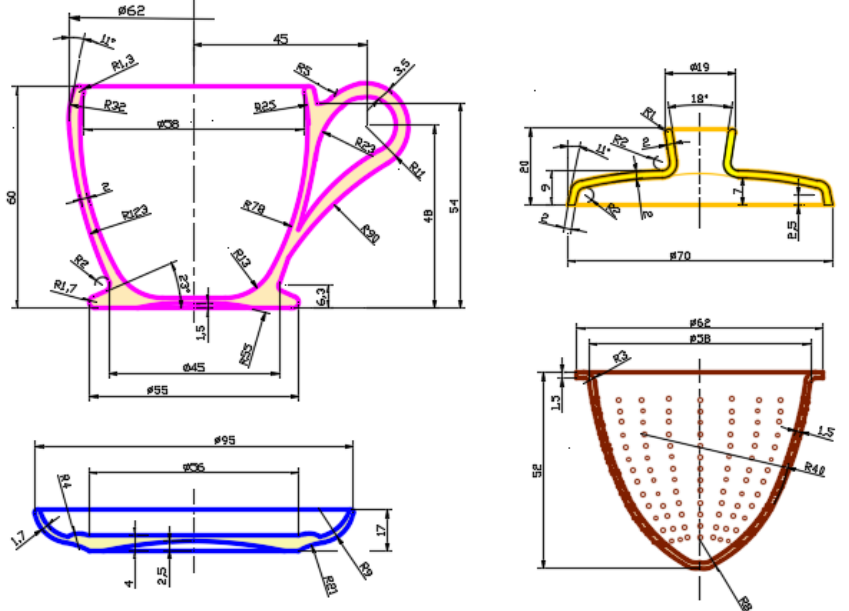
Figure 6. Sizing geometric elements (survey section profiles) in the AutoCAD environment: set toy for children—teacup.